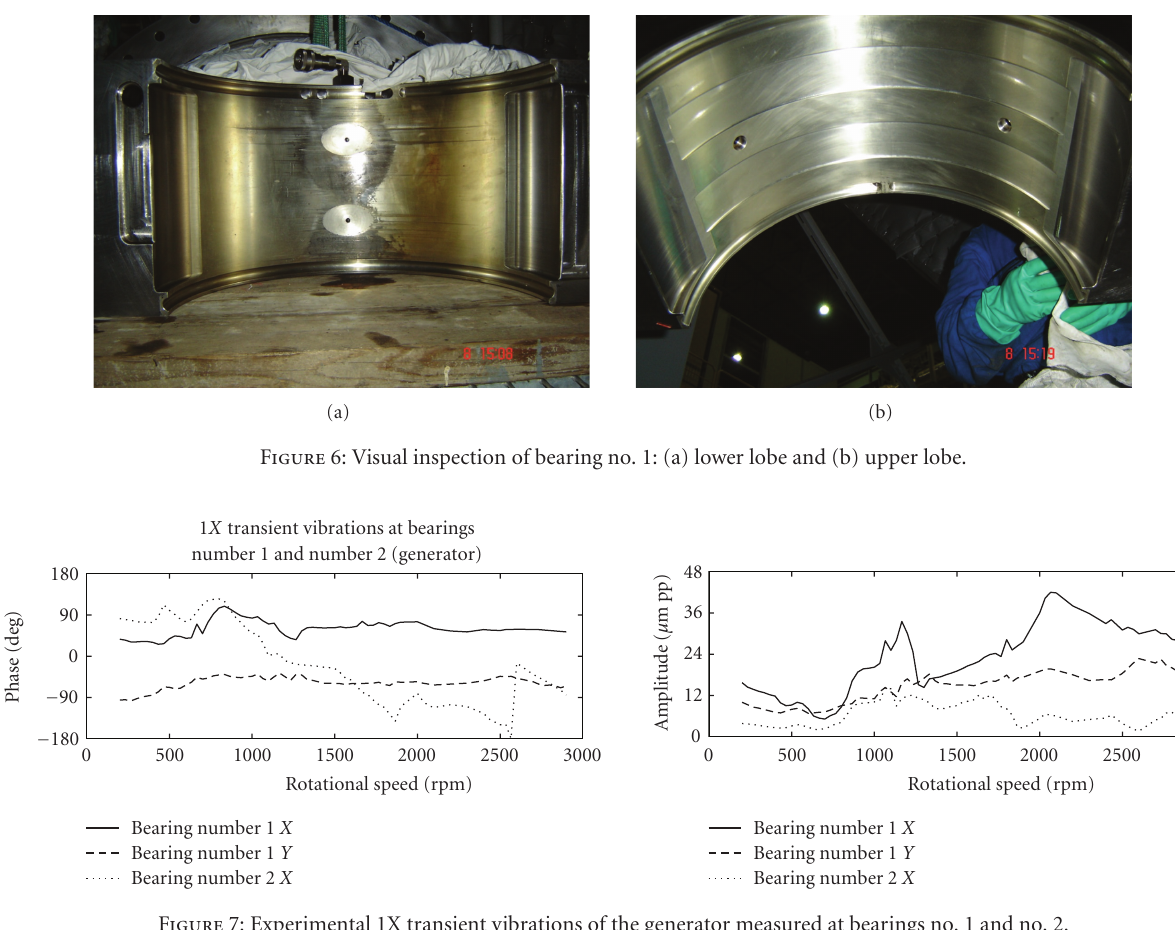
Figure 7: Experimental 1X transient vibrations of the generator measured at bearings no. 1 and no. 2.